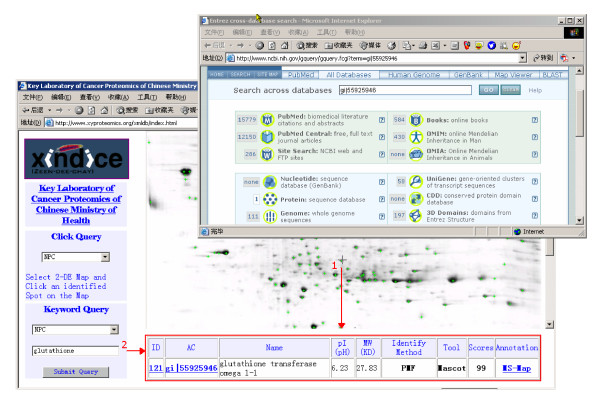
An example of clicking a clickable spot or keryword query. An example of query result was displayed in the client browser. Two methods to query the NPC 2D/MS repository were provided, one is to click the clickable spot and the other is to query with keyword. The user could see the position of spot on the gel through the hyperlink of ID and other information about the spot such as pI, MW, accession number, scores of Mascot or other database search software and etc. Through the hyperlink of accession number in the NCBI, the user could get more information about this protein directly without searching again in NCBI.